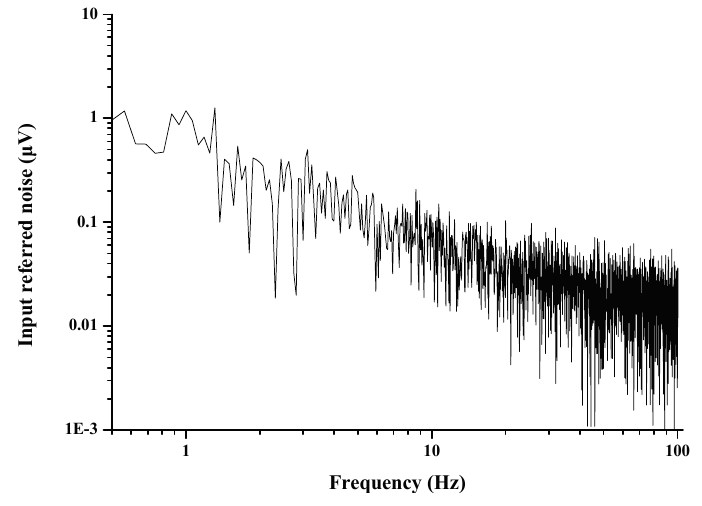
Figure 17. Measured IRN in band-width from 1 Hz to 100